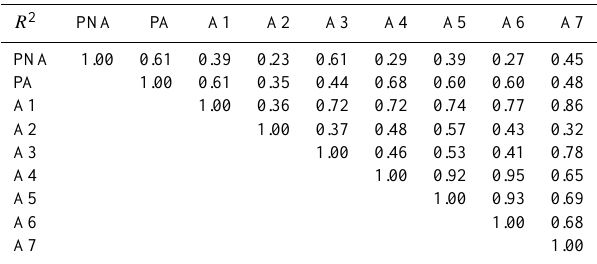
Table 2. Correlation table of α -pinene oxidation products revealing three sets of compounds with similar trends: Set 1 includes PNA, PA, and A2, products formed at the early stages of the reaction. Set 2 includes A4, A5 and A6, products that appear at later stages of the reaction and that show a relative increase with OA’s oxidation state (Fig. 10). Set 3 includes A1, A3 and A7, products that appear at later stages of the reaction but do not show any increase with OA’s oxidation state (Fig. 10).